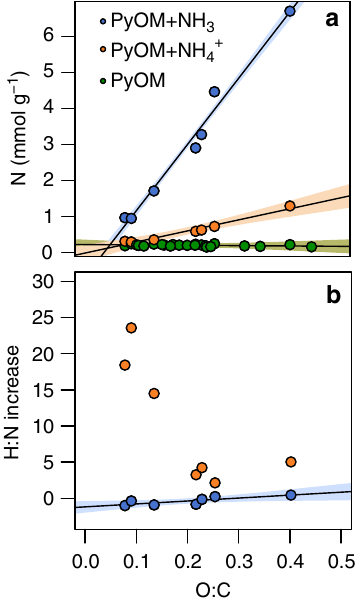
Fig. 2 Pyrogenic organic matter N content and H:N ratio following exposure to ammonium or ammonia. a Pyrogenic organic matter (PyOM) nitrogen (N) retention in mmol g − 1 PyOM – carbon (C) measured by dry combustion is signi fi cantly associated with molar O:C ratios following exposure to NH 3 and NH 4 + ( y = 18.25 x – 0.0665, p < 0.001 and y = 3.045 x − 0.008, p < 0.001, respectively). b H:N molar increases are signi fi cantly associated with O:C ratios following exposure to NH 3 ( y = 6.23 x − 1.70, R 2 = 0.59, p < 0.005, F 1,10 = 14.45, RSE 10 = 0.53), but not NH 4 + . PyOM samples retain <0.5 moles of NH 3 – H for every mole of NH 3 – N retained, compared to 2.13 – 23.60 moles of NH 4 + – H for every mole of NH 4 + – N retained. Green symbols represent original PyOM samples without N addition, orange symbols represent PyOM following exposure to NH 4 + , and blue symbols represent PyOM following exposure to NH 3 . Shaded bands represent the 95% con fi dence